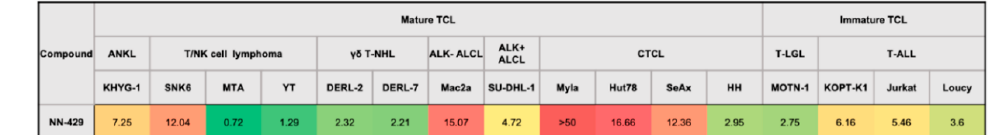
8 of 21 Figure 6. ( a ). PAMPA and plasma stability evaluation of NN-429. ( b ). In vivo PK profile of NN-429 (IP; 50 mg/kg), in male CD-1 mice ( n = 3). ( c ). In vivo PK parameters of NN-429 (IP; 50 mg/kg), in male CD-1 mice ( n =